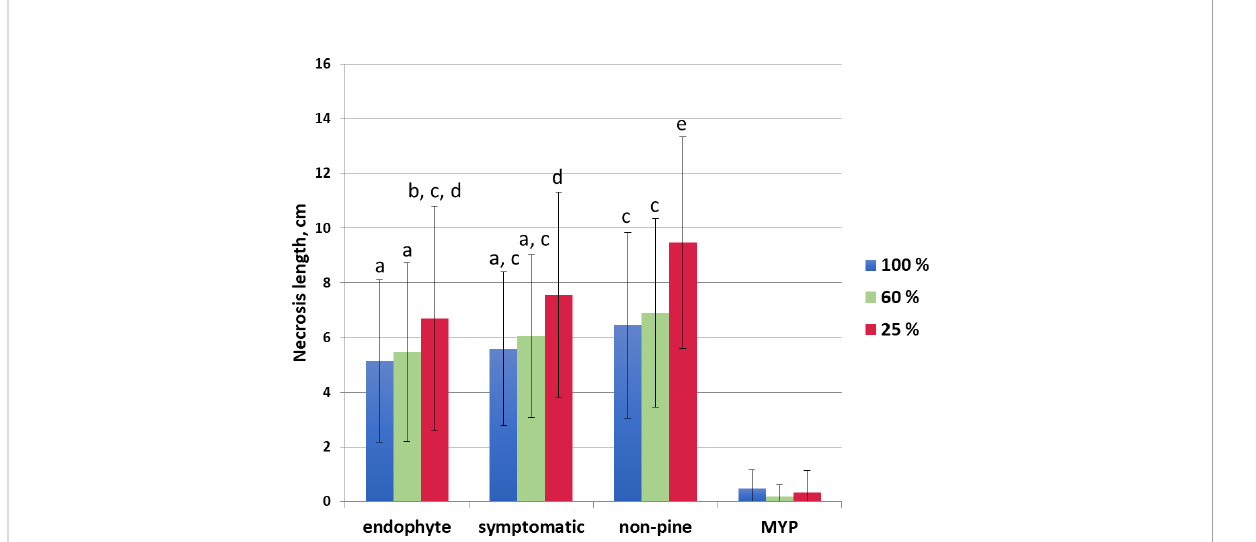
FIGURE 2 Necrosis length in cm of the side shoots for the different water treatments (100% blue, 60% orange, 25% red) grouped according to the D. sapinea strain ’ s origin (isolated from symptomless material = endophytic, from symptomatic material = symptomatic, isolated from non-pine hosts = non-pine and for the control the mock-treatment with MYP-agar plugs = MYP). The letters indicate the statistical